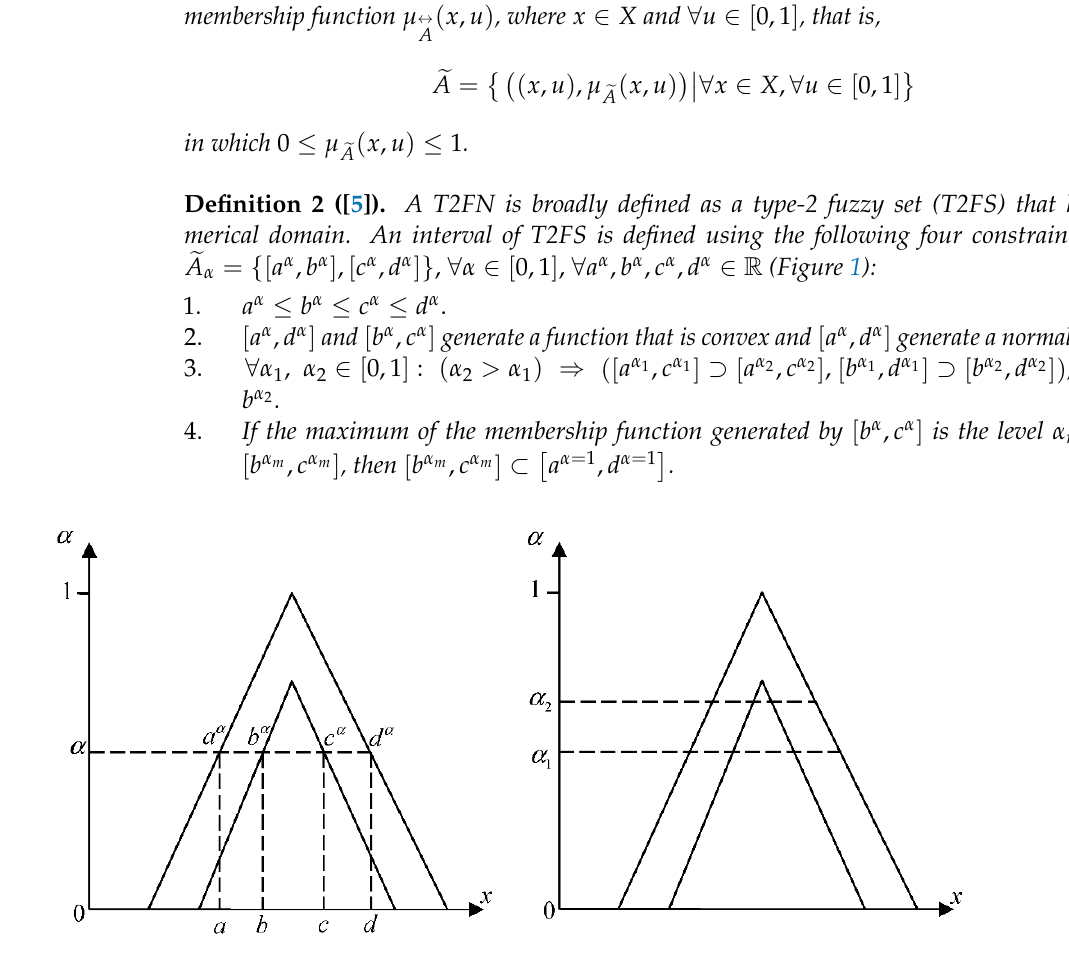
Figure 1. Definition of an IT2FN.